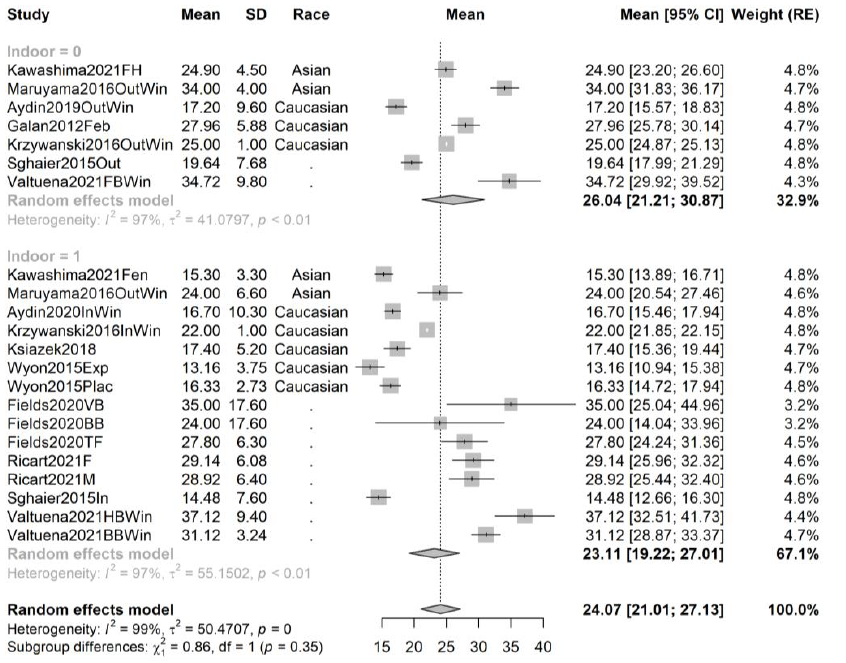
Figure 9. Forest plot of all studies performed in winter sorted by athletes’ race. Studies [40,47,49,56,58,62,63,66,67,70,71].